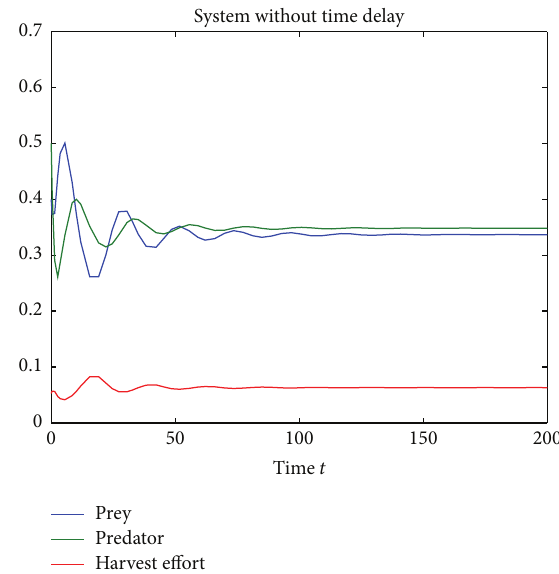
Figure 3: The positive equilibrium 𝑃 ∗ of system (6) with 𝜏 = 0 is locally asymptotically